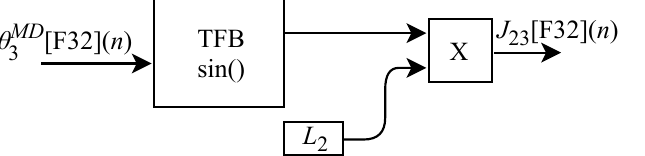
Figure 24. Proposed circuit to calculate the Jacobian matrix J 23 [ F 32 ]( n ) (Equation (36))—JM.